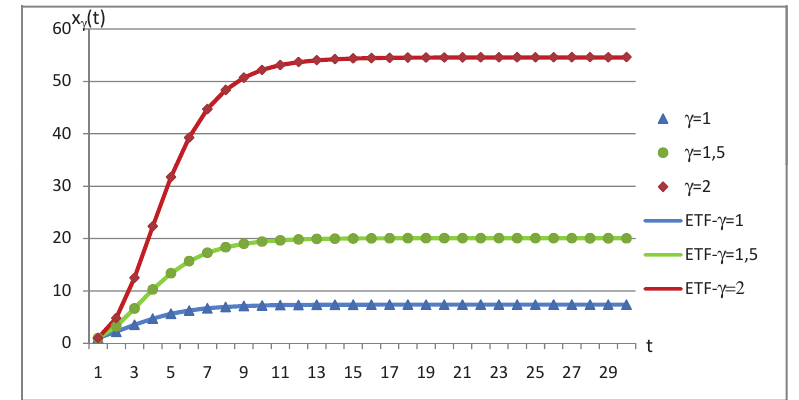
Figure 1. Fit and prediction based on ETF.